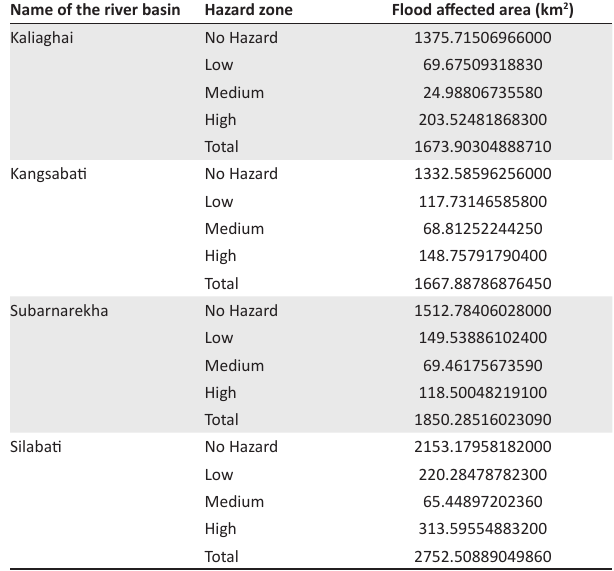
FIGURE 10: (a) Flood hazard map of Kaliaghai Catchment and (b) Subarnarekha Catchment. TABLE 5: Vulnerability of the population according to flood hazards zone.